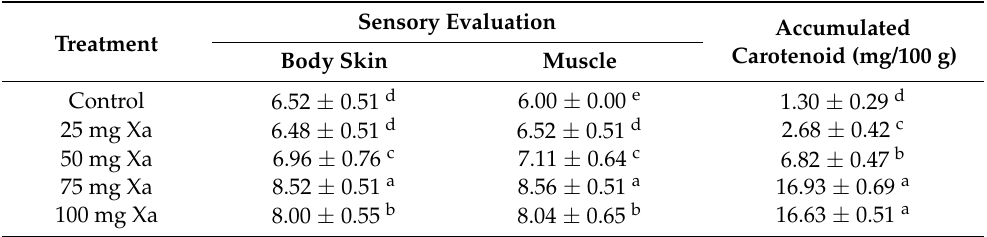
Table 7. Sensory evaluation and accumulated carotenoid in muscle of fish fed of bighead catfish fed Xa diets for 4 weeks.